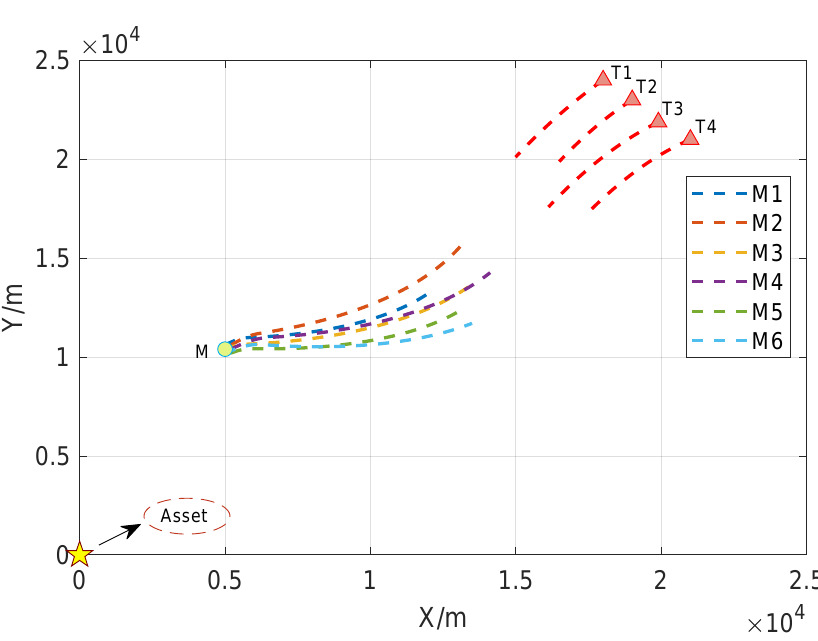
Figure 3. Initial positions and trajectories of the interceptor and the target.